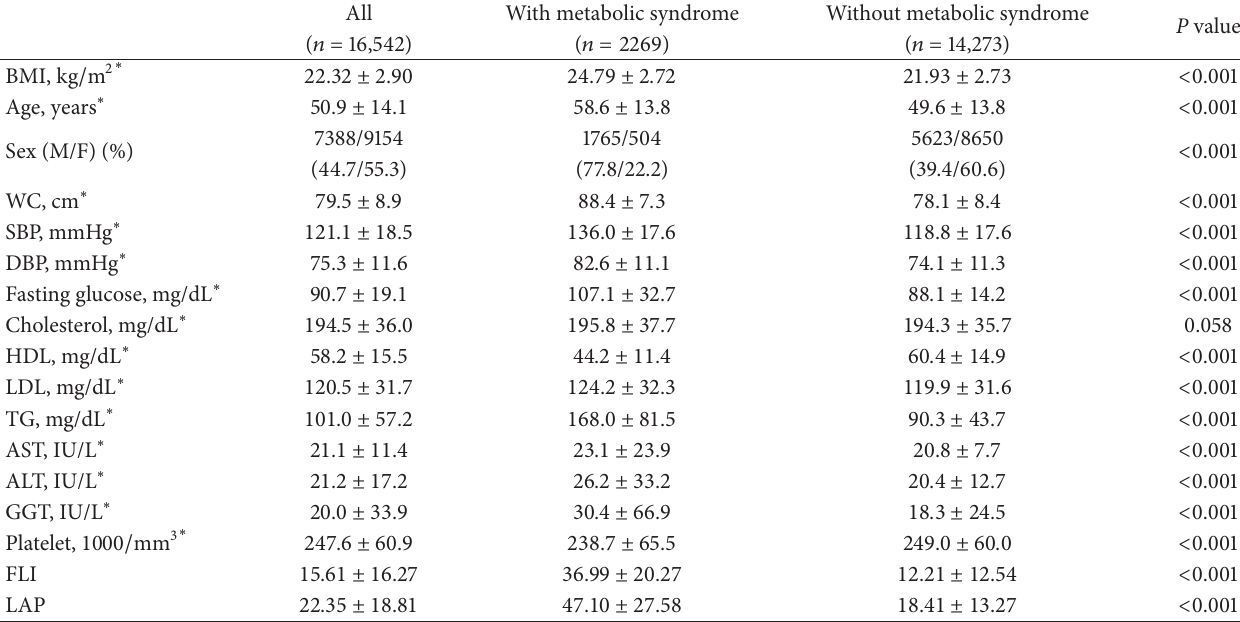
Table 6: Characteristics of non-fatty liver subjects with and without metabolic syndrome.